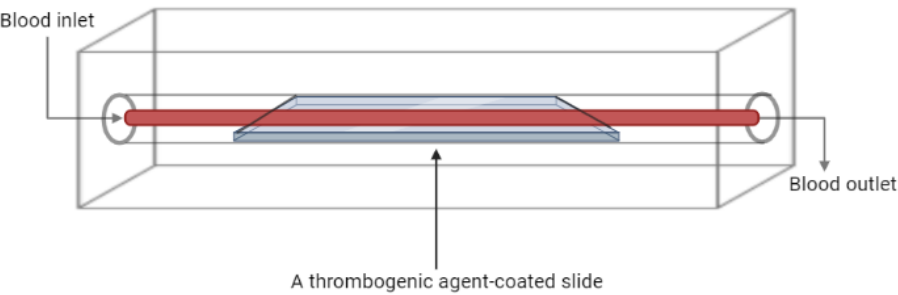
Figure 2. Schematic diagram of a flow chamber-based thrombosis model (Created with BioRen- der.com).